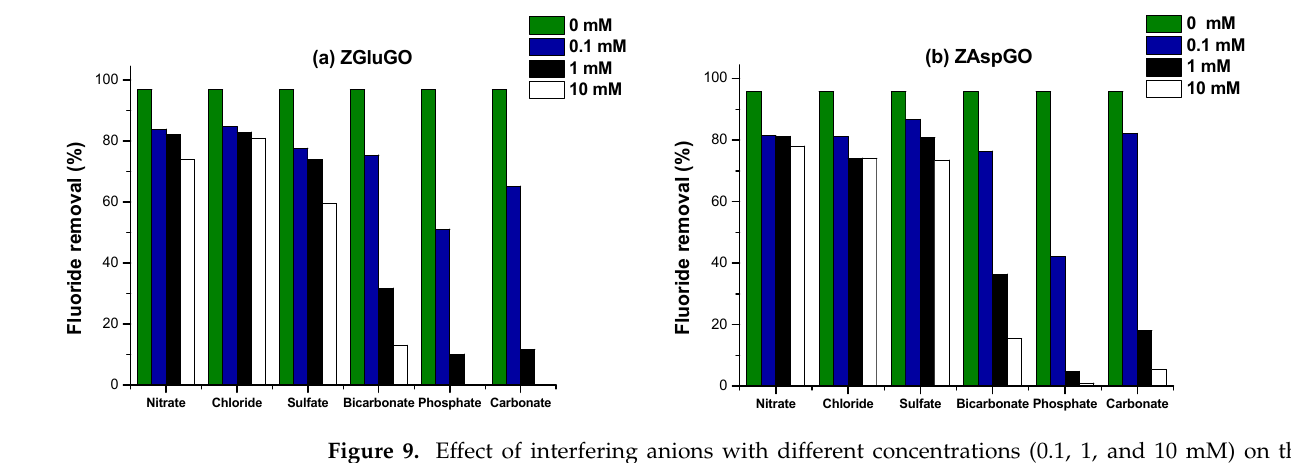
Figure 9. Effect of interfering anions with different concentrations (0.1, 1, and 10 mM) on the fluoride ion-removal efficiencies (F − initial concentration was constant, 10 mg/L) ( a ) ZGluGO and ( b ) ZAspGO at 25 °C. Table 3. Comparison of different zirconium-containing fluoride ion adsorbents (AC: adsorption capacity; pH: functional pH range; CT: contact time).